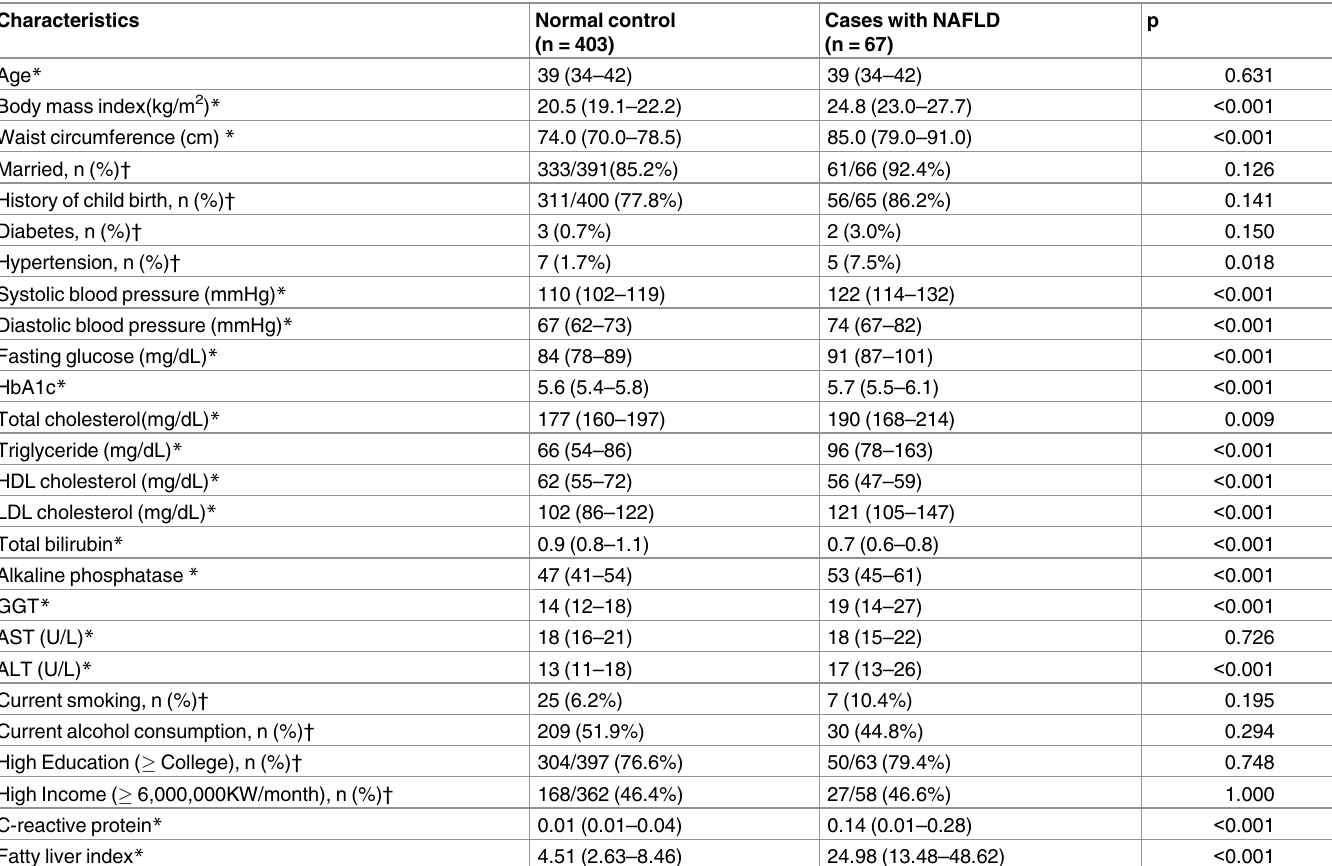
Table 1. Characteristics of premenopausal women according to the presence or absence of non-alcoholic fatty liver